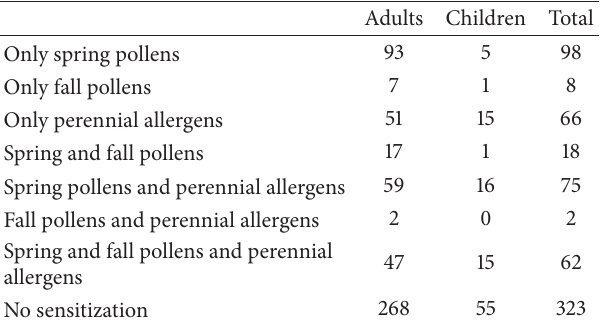
Table 1: Allergic